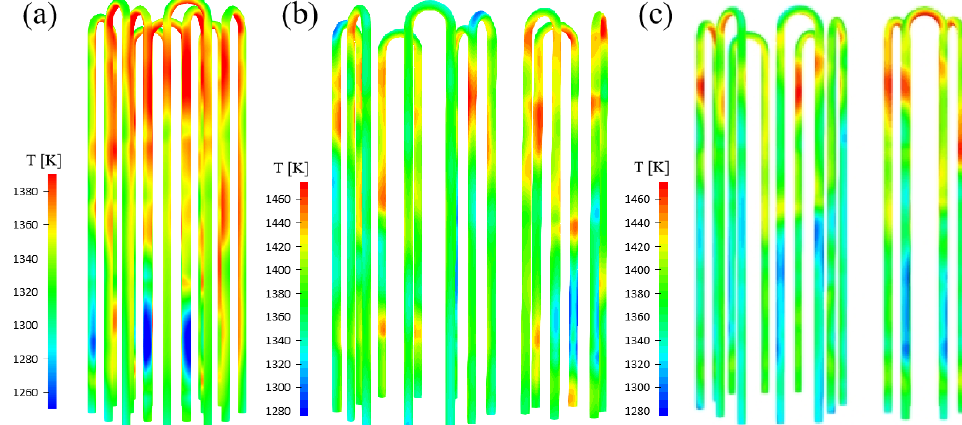
Figure 5. Temperature distribution along rod surface. ( a ) Design A; ( b ) design B; ( c ) design C.